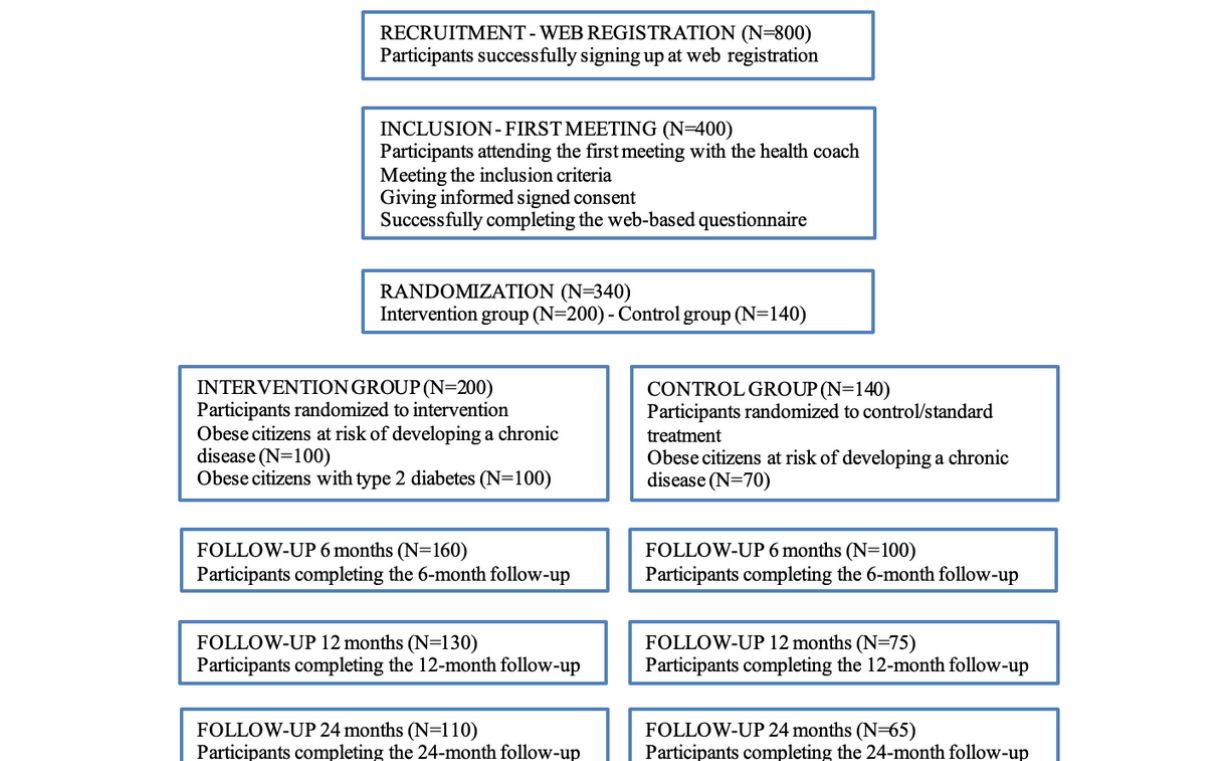
Figure 1. Illustration of participant